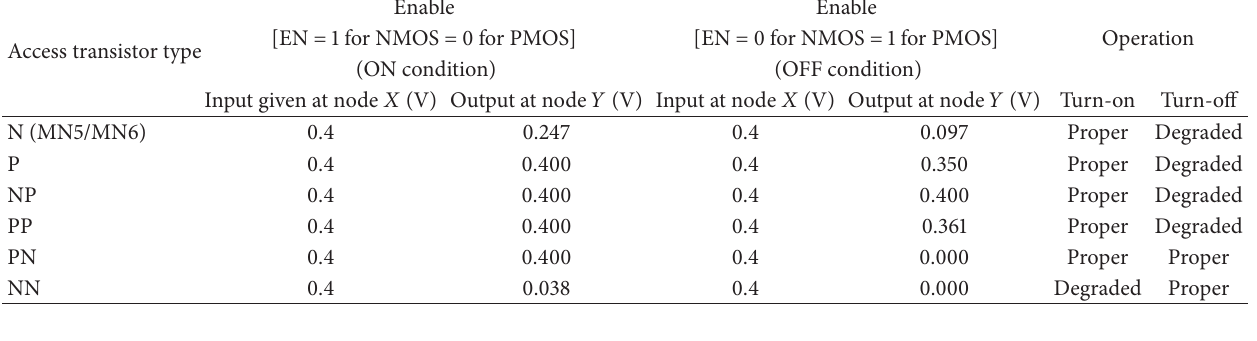
Access transistor type